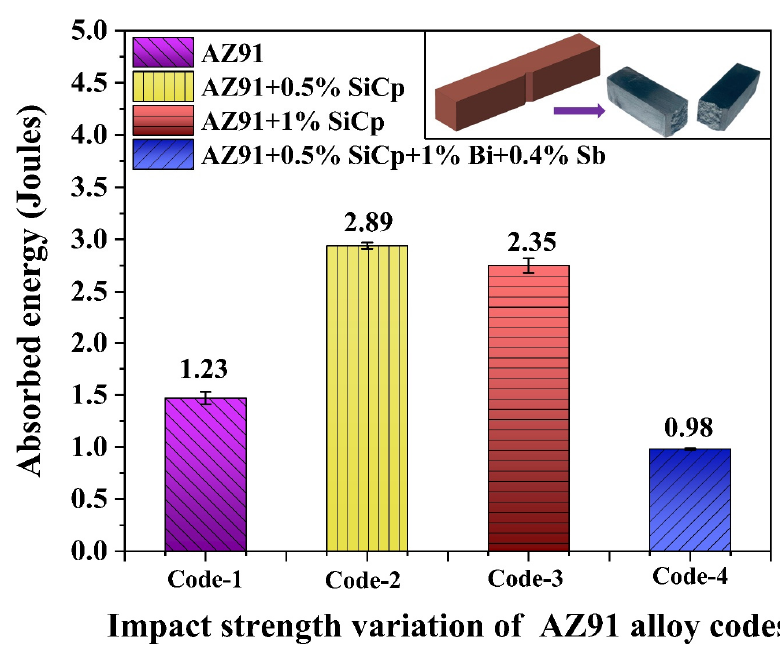
Figure 6. Charpy impact test and absorbed impact energy of pure and modified AZ91 alloys. Table 6. Variations in the Charpy impact energy of pure AZ91 and AZ91/ β -SiCp/Bi/Sb composites. Alloy